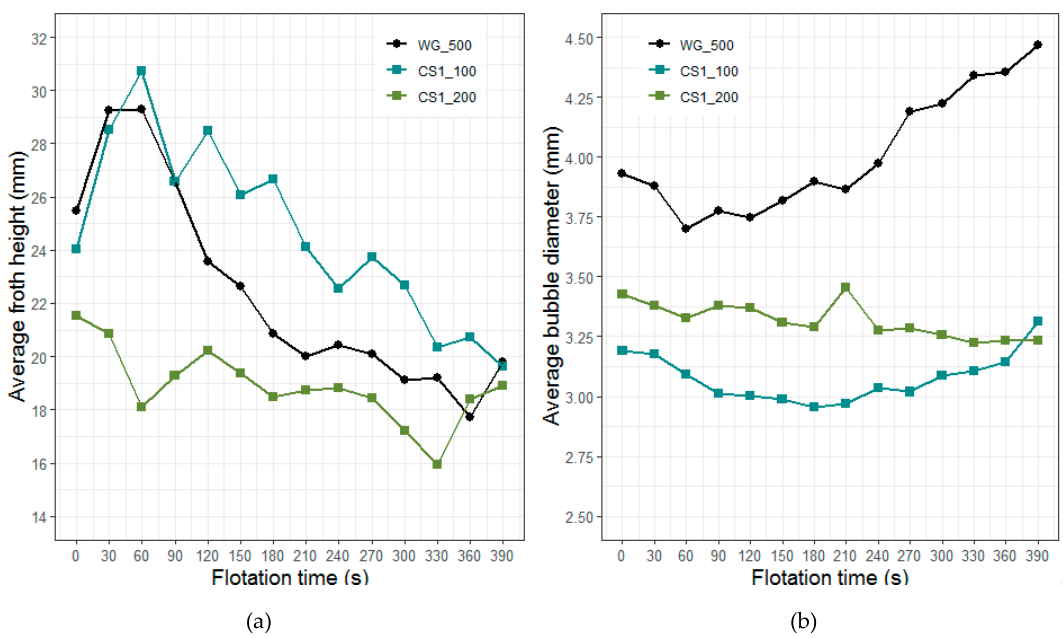
Figure 8. ( a ) Thirty-second average froth height and ( b ) bubble diameter over flotation time for WG_500, CS1_100 and CS1_200.